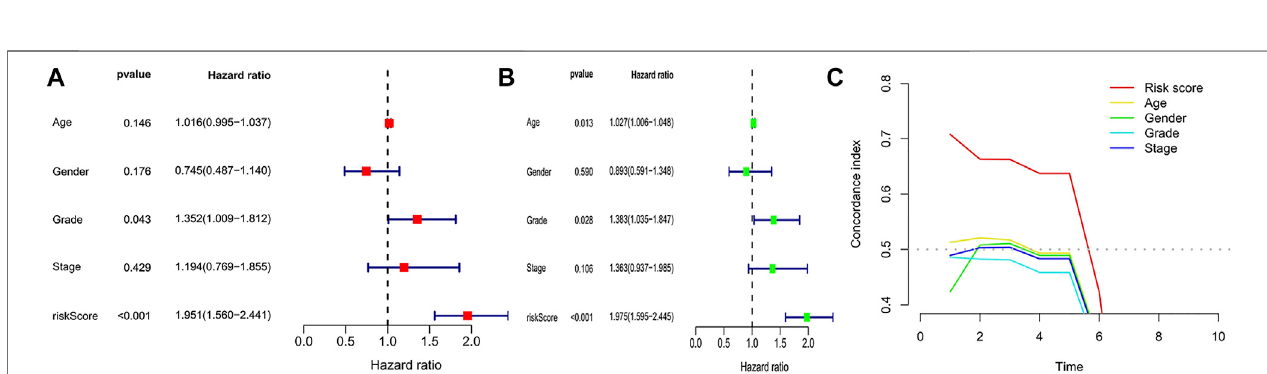
FIGURE1|(A) Co-expressionofm6Aregulatorygenesand related lncRNA. (B) Coxunivariate analysisofm6Aregulatorygene. (C) ThetuningparametersofOS- related proteins to cross-verify the error curve. (D) Perpendicular imaginary lines to calculating the minimum criteria. (E) Correlation heatmap of 3 m6a associated lnCRNAs.